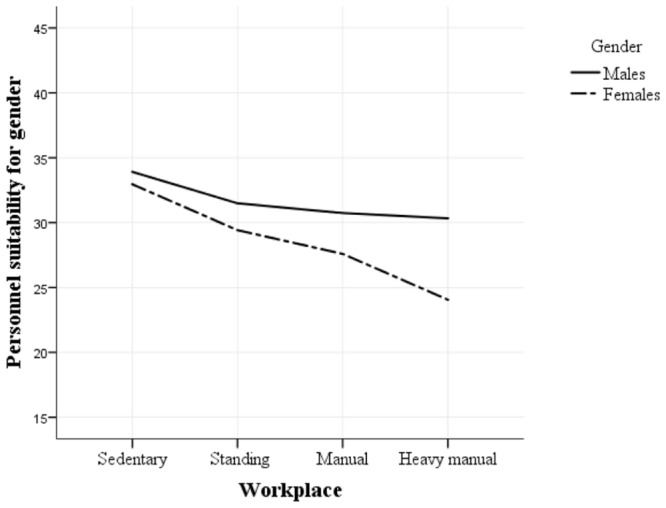
Gender difference across workplace activity level.